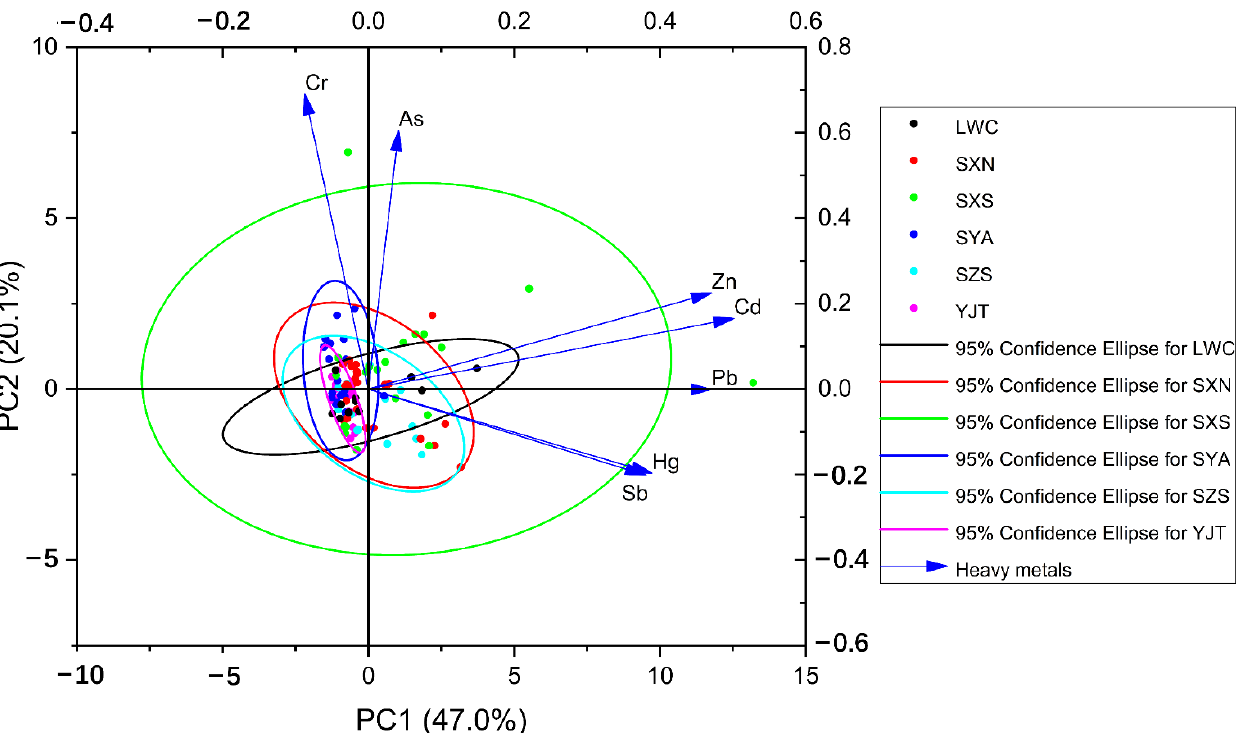
Figure 3. Principal component analysis of the total PTEs